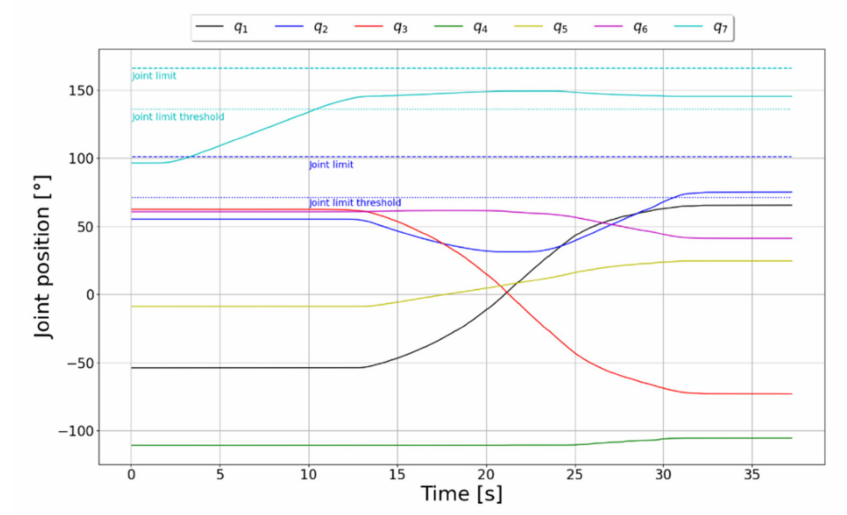
Figure 21. Joint position trajectories when applying the adaptive JLA strategy.